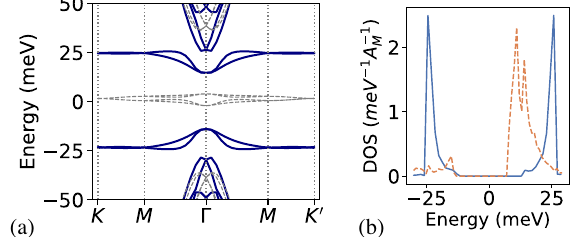
FIG. 4. (a) HF band spectrum of the K-IVC state that solves the self-consistency equations when six bands per spin and valley are used. The parameters were θ ¼ 1 . 05 °, w 0 ¼ 78 meV, w 1 ¼ 105 meV, and ϵ ¼ 9 . 5 . The gray dashed lines correspond to the original BM band spectrum. (b) DOS of the K-IVC state at charge neutrality (solid blue line) and the self-consistent HF solution with empty flat bands, i.e., at filling ν ¼ − 4 (dashed orange line). Here, A the area of the moir´e unit cell.